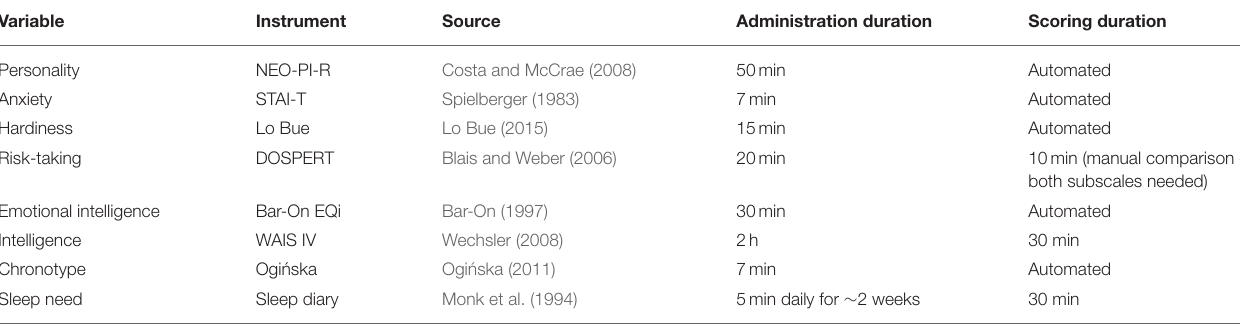
TABLE 2 | Summary of the psychometry tools used for mapping of the selected trait variables.